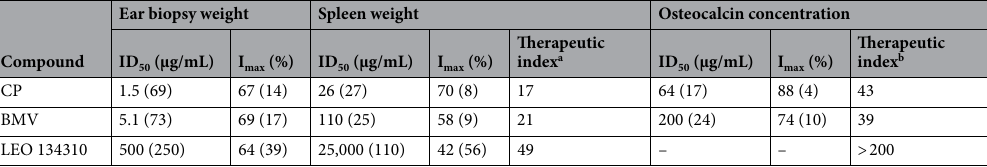
Table 5. Higher therapeutic index for LEO 134310 vs CP and BMV in the TPA-induced skin inflammation mouse model. Calculated inhibitory doses (API concentration in formulation) to reach 50% of I max effect on ear biopsy weight, spleen weight and osteocalcin concentration (ID 50 ) and estimated therapeutic index (TI). CV (%) within brackets. a Therapeutic index (Spleen ID50/Ear ID50). b Therapeutic index (Osteocalcin ID50/ Ear